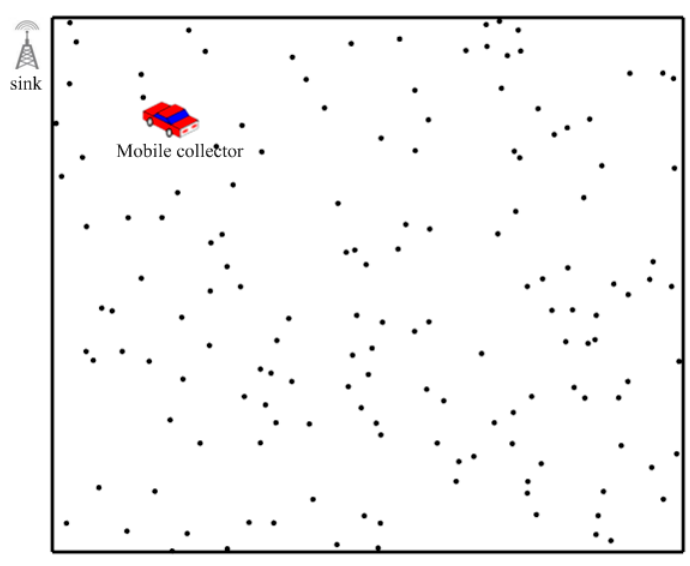
Figure 4. Network Figure 4. Network model.